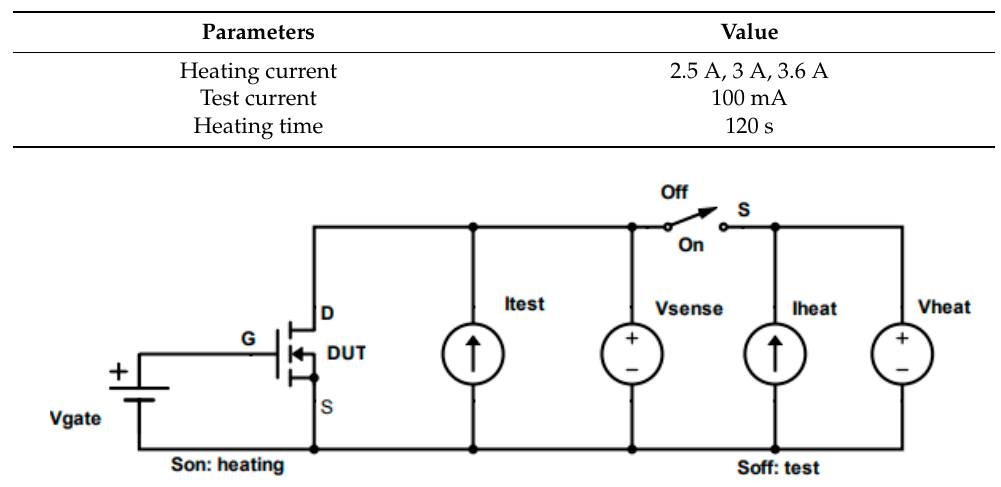
Figure 7. V ds measurement setup. During the measurement, three different heating currents were used (2.5 A, 3 A, and 3.6 A). For each of them, 10 measurements were performed to ascertain the robustness of the method. Some of these measurements are reported in Figure 8 where, during the in- terval labelled “1”, the device was at room temperature with no heating current, so the value of V ds was measured for a current equal to 100 mA. Figure 8. Trend of V ds. Once the heating current pulse is applied (“2”), V ds instantaneously increased signif- icantly due to the large current. Then, the device began to heat up and, consequently, V ds increased further. When the pulse vanished (“3”), the heating current no longer flowed into the device and only the sensing current flow remained. Consequently, the cooling